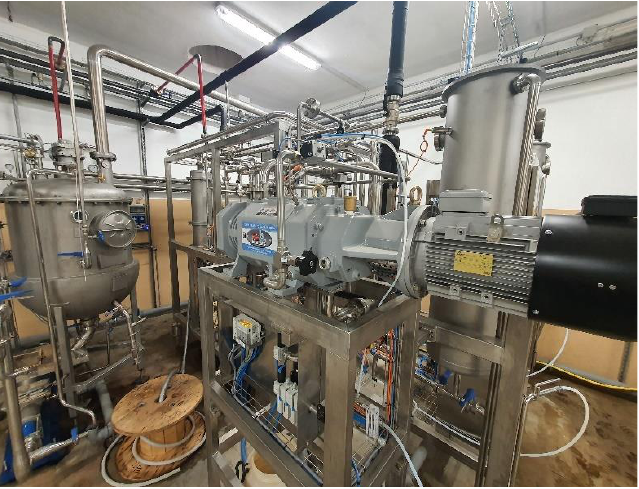
Figure 8. Flash evaporation unit (C2FUT Srl.) DSTF — University of Turin.